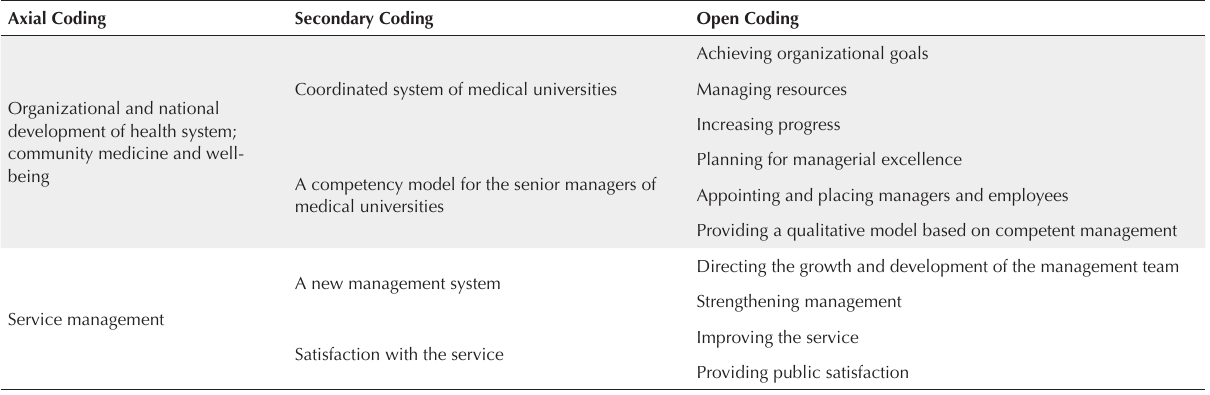
Table 5. Axial coding of qualitative data (consequences) Axial